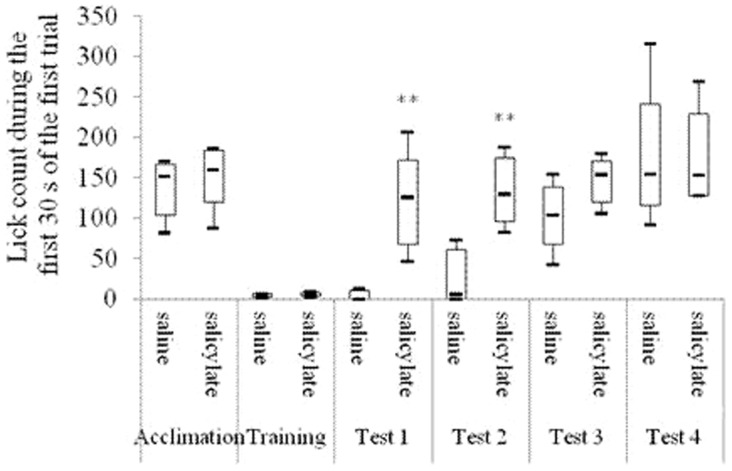
Lick count during the first 30 s of the first trials in different behavioral periods. “Acclimation” shows the average of the lick count of all rats in the saline or the salicylate group in the 2-day acclimation period; “Training” shows the average of the lick count of all rats in the saline or the salicylate group in the 7-day training period; Tests 1–4 show the 1st, 2nd, 3rd, and 4th day in the test period, respectively. **P<0.01 is compared with the saline group.